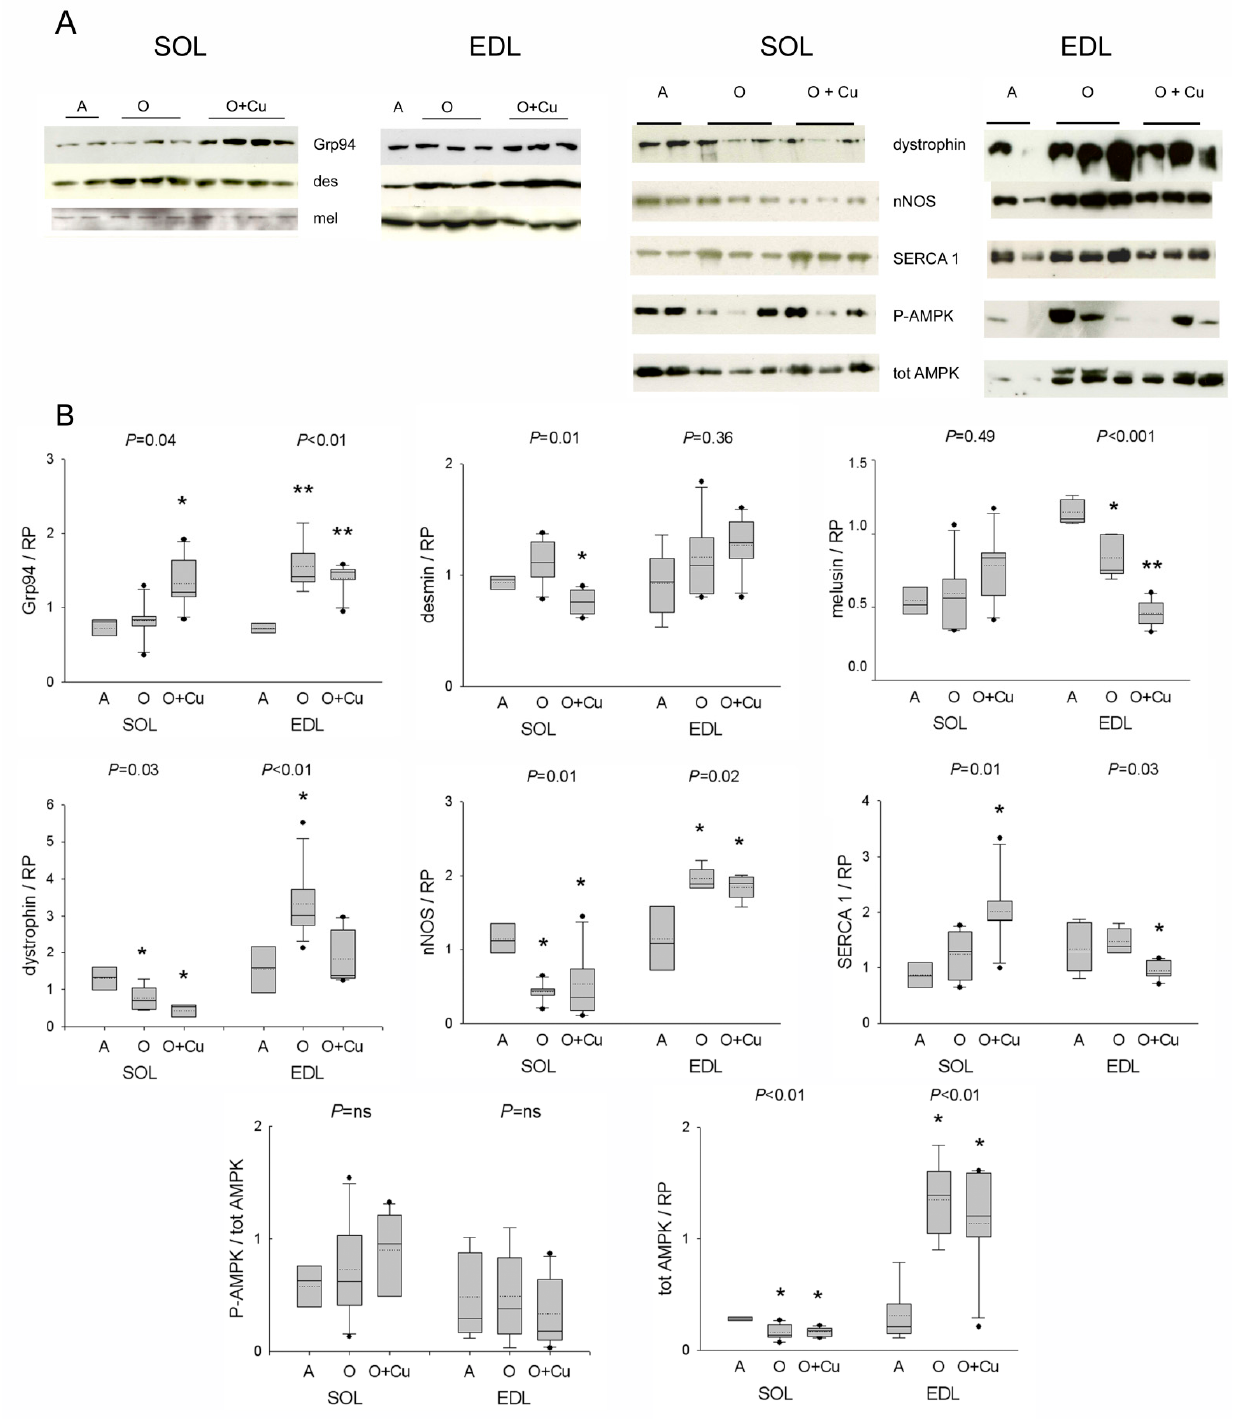
Figure 5. ( A ) Representative Western blots of costameric and regulatory proteins of soleus and EDL of 10ScSn mice. Samples correspond to soleus (SOL) and EDL muscles from Adult mice (A), vehicle-treated Old mice (O) and curcumin-treated Old mice (O + Cu) (see Supplementary Materials for loading reference). ( B ) Box plots of normalized values to total loaded protein stained with Red Ponceau (RP). Soleus and EDL data are expressed in arbitrary units relative to the corresponding adult values. Mean and median values are indicated by dotted and solid lines, respectively. n of soleus or EDL samples was A = 4; O = 5 or 6; O + Cu = 6. Comparisons were performed among groups of the same muscle. Indicated p value corresponds to ANOVA test; single or double asterisk indicates the presence of significant difference vs. A, or O, or both, after post-hoc analyses, as detailed in the